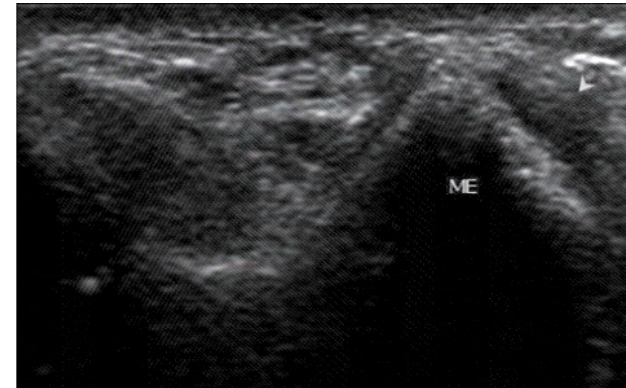
Fig. 4. At full flexion, the ulnar nerve along with the medial head of the triceps have dislocated (shown by the arrowhead) over the medial epicondyle (ME). The dislocation was perceived as a snapping sensation felt through the transducer.